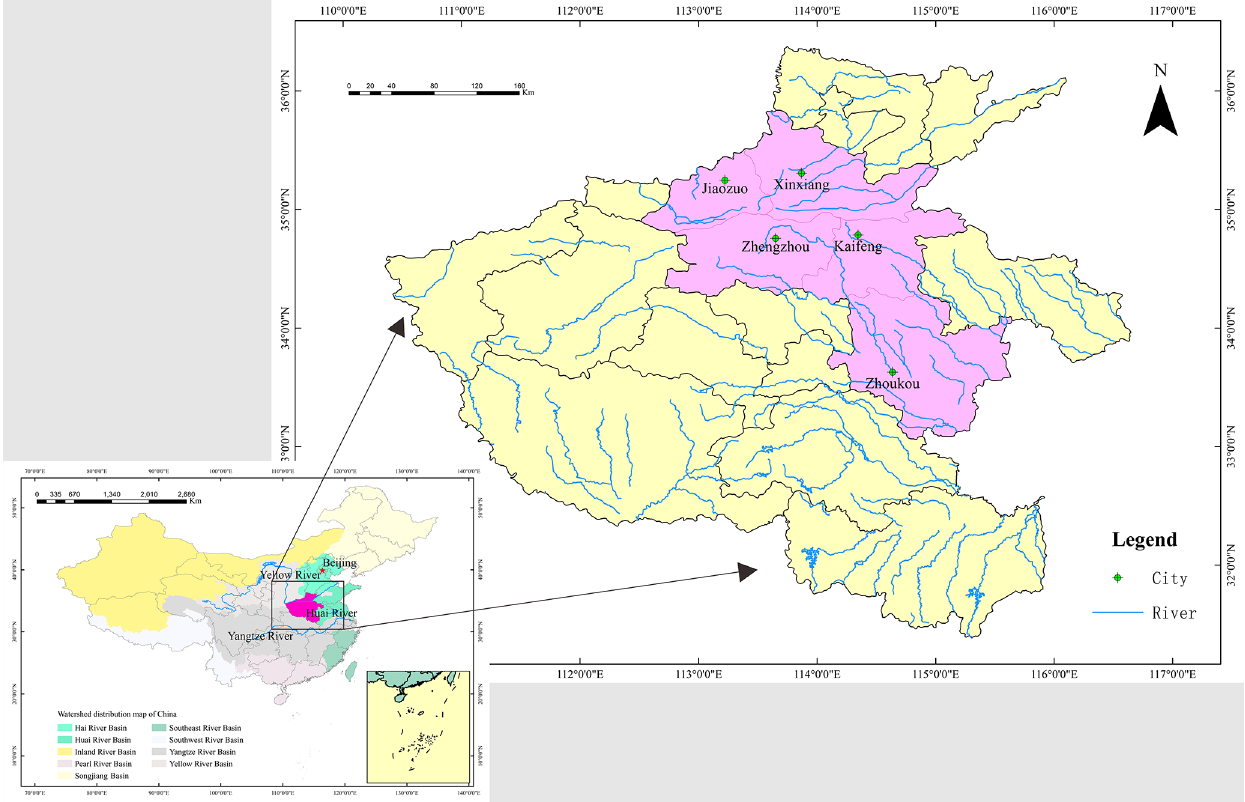
Figure 2. Location of the survey